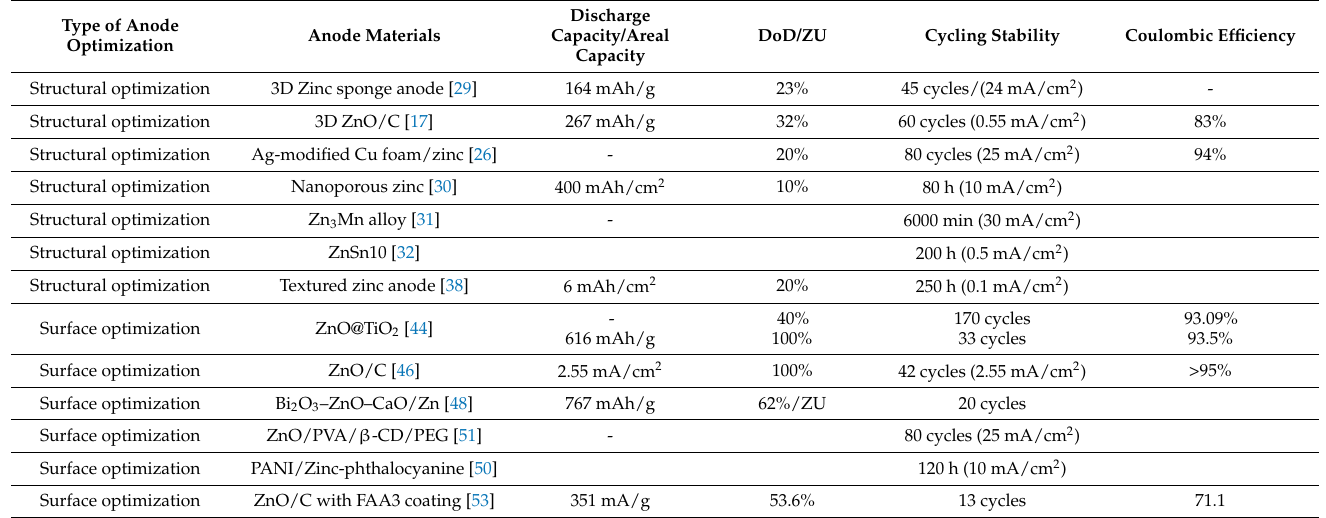
Table 1. Summary of research articles focused on zinc anodes optimization and a selection of their performance criteria (last five